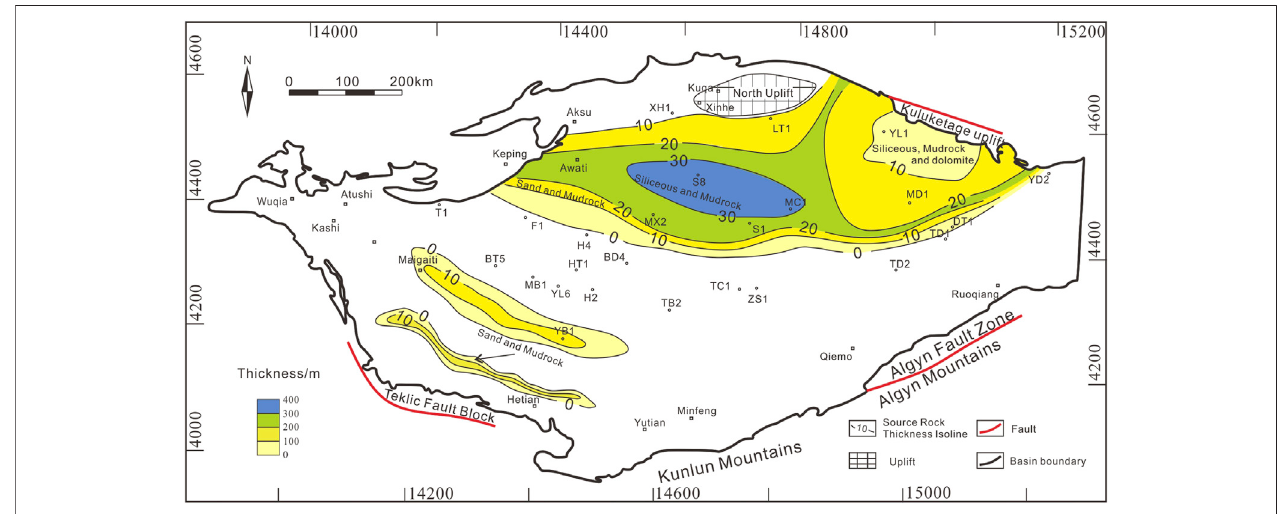
FIGURE 13 | Distribution of the Yuertusi source rocks at the Sinian – Cambrian boundary (modi fi ed from Jin et al., 2017; Shi et al., 2018).